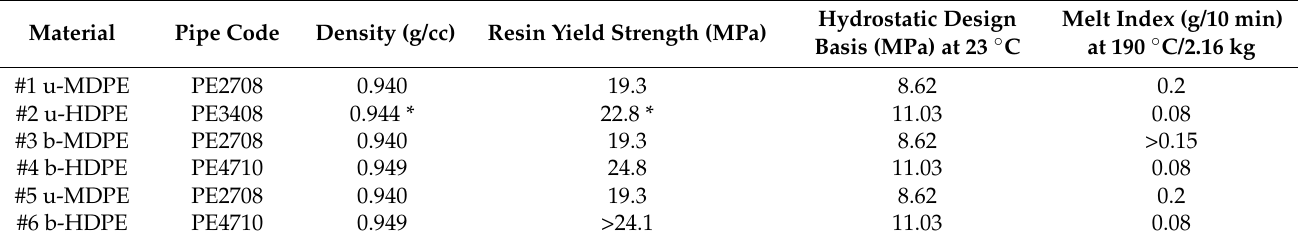
Table 1. Material characteristics of the PE pipes used in the study, which are identical to those in ref.